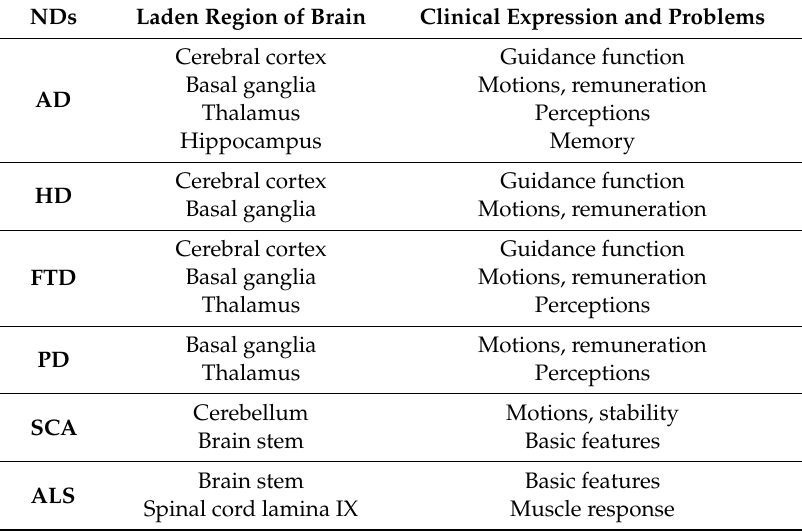
Table 5. Summary of select NDs